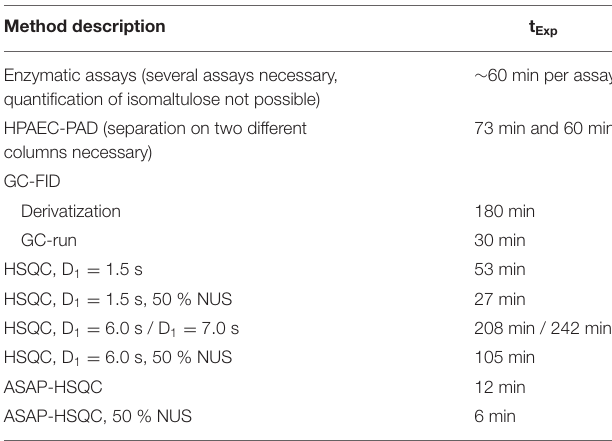
TABLE 1 | Experiment times (t Exp ) for the quantification of D -glucose, D -galactose, D -fructose, sucrose, lactose, maltose, and isomaltulose with the described